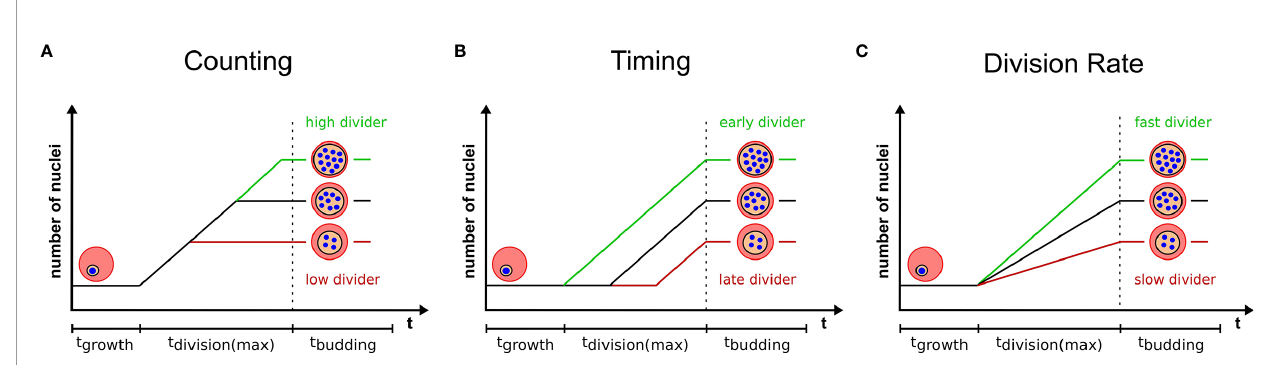
FIGURE 2 | Three models highlighting variables that can contribute to progeny number. Variation in progeny number can be explained by changes in several cellular parameters. Relative number of nuclei are plotted against the total duration of blood stage development, which is divided in growth, division, and budding phase. The longest division time is marked, which starts with the fi rst and ends with the last nuclear division. Time axes are neither to scale nor proportional. Three models provide a visual representation of changing a single determinant which limits the fi nal progeny number and explain the variability within a single parasite population. Extrinsic or intrinsic factors can contribute to either an increase (green) or a decrease (red) of progeny number by (A) in fl uencing the pre-set target number (counting), (B) initiating division at different times (timing) or (C) altering the rate of division of individual